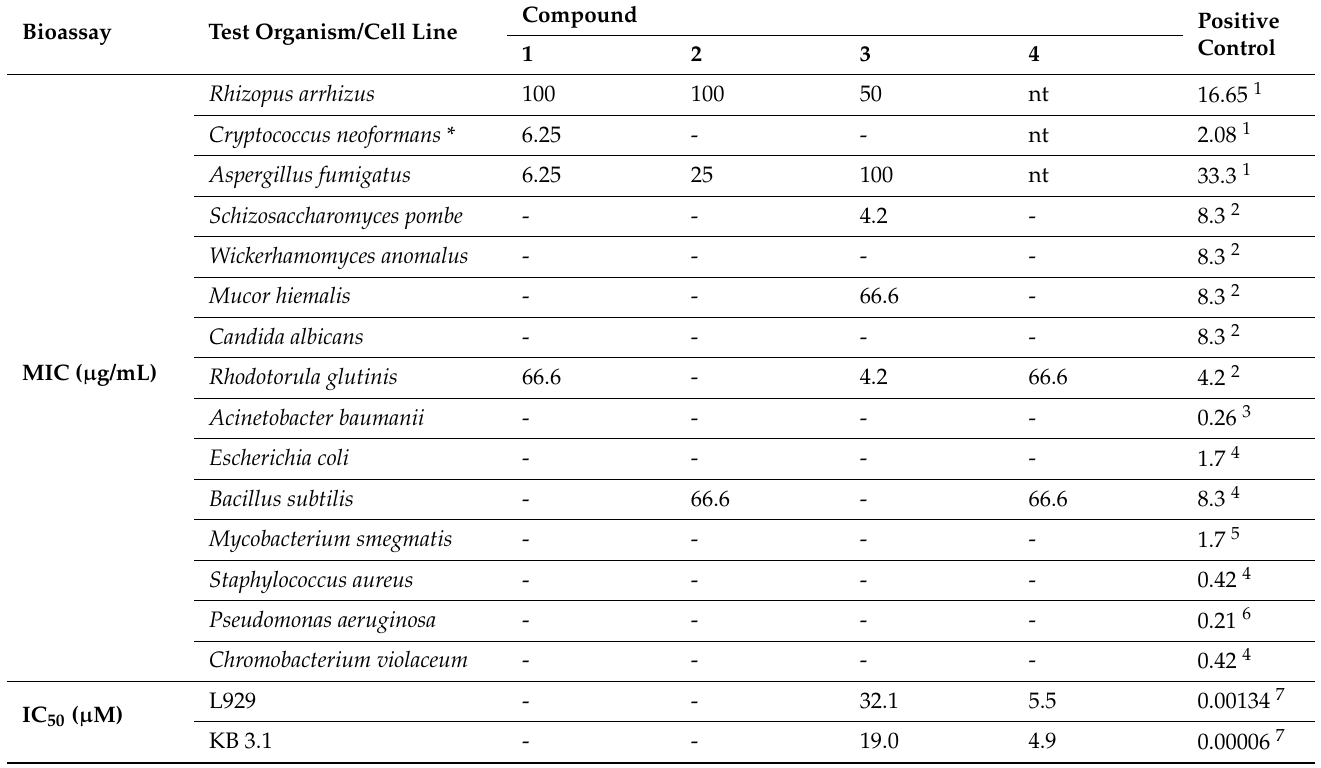
Table 2. Minimum inhibitory concentration (MIC, µ g/mL) against bacterial and fungal test organisms, and half-maximal inhibitory concentrations (IC 50 , µ M) against mammalian cell lines of compounds 1 – 4 . 1 cycloheximide, 2 nystatin, 3 ciprobay, 4 oxytetracycline, 5 kanamycin, 6 gentamicin, 7 epothilone B, -: no inhibition observed under test conditions, nt: not